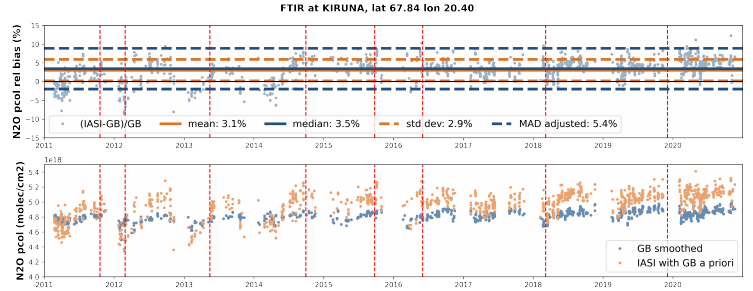
Figure 17. Same as Figure 16 for the NDACC Kiruna